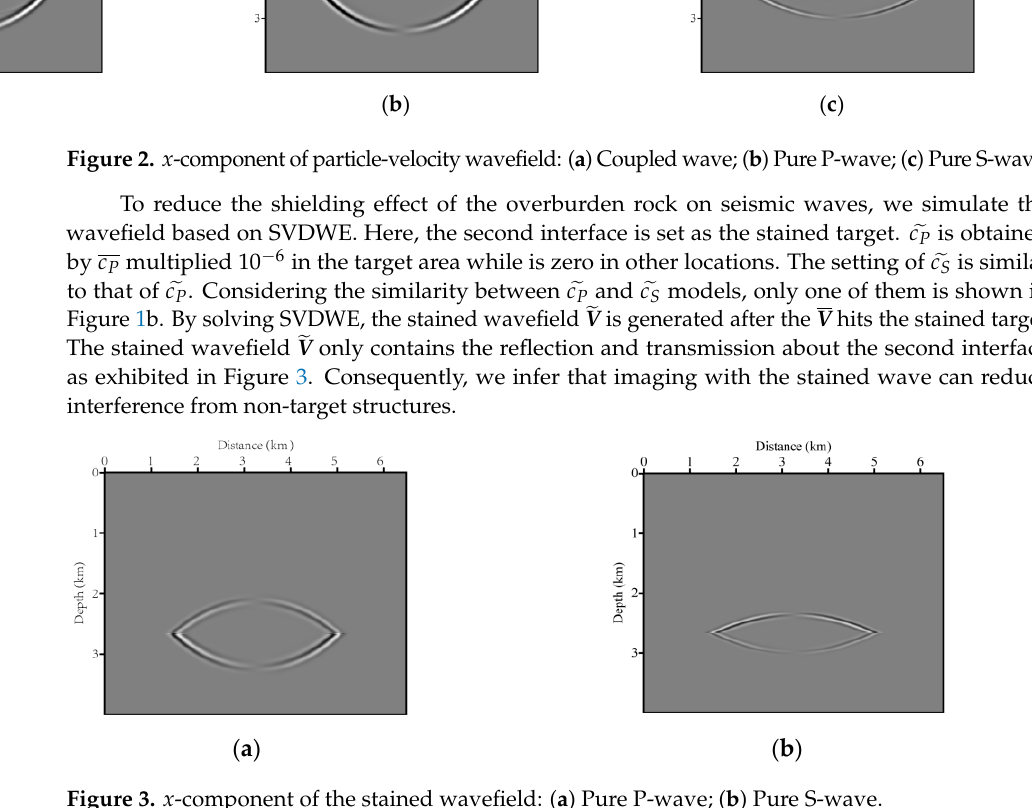
Figure 2. 𝑥 -component of particle-velocity wavefield: ( a ) Coupled wave; ( b ) Pure P-wave; ( c ) Pure S-wave.